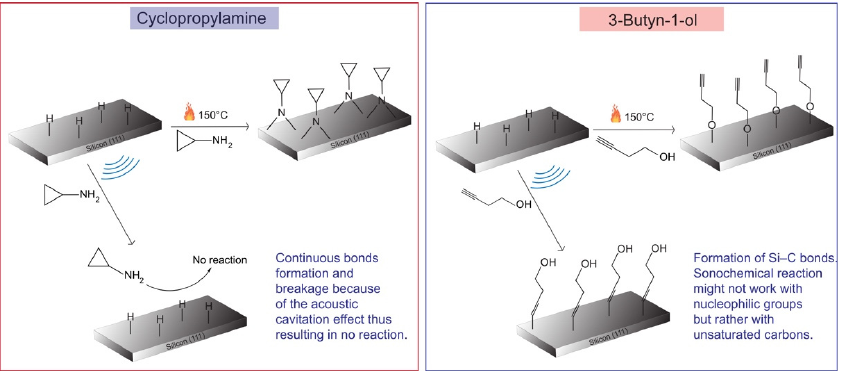
3-Butyn-1-ol during high-temperature thermal and sonochemical